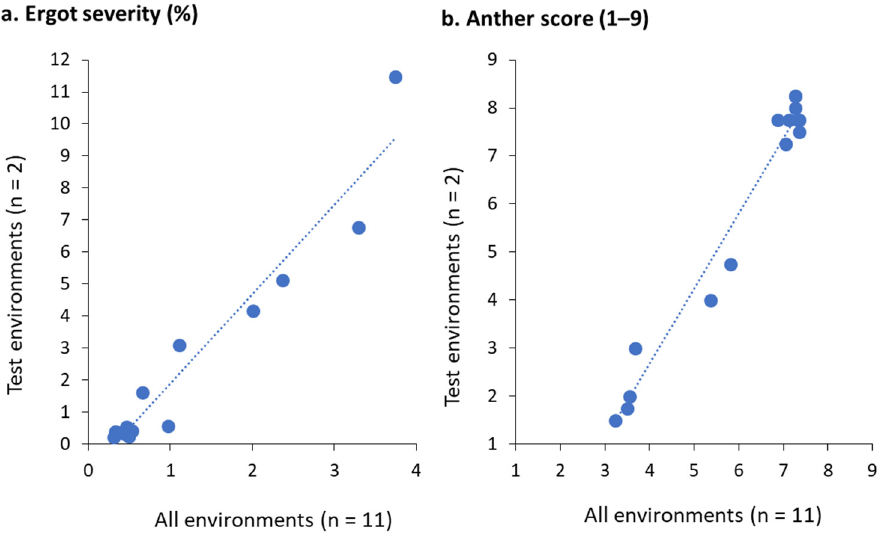
Figure 1. Association across all environments vs. test environments for 15 single crosses after inoculation with C. purpurea for ( a ): ergot severity (%) and ( b ): anther score (1–9).